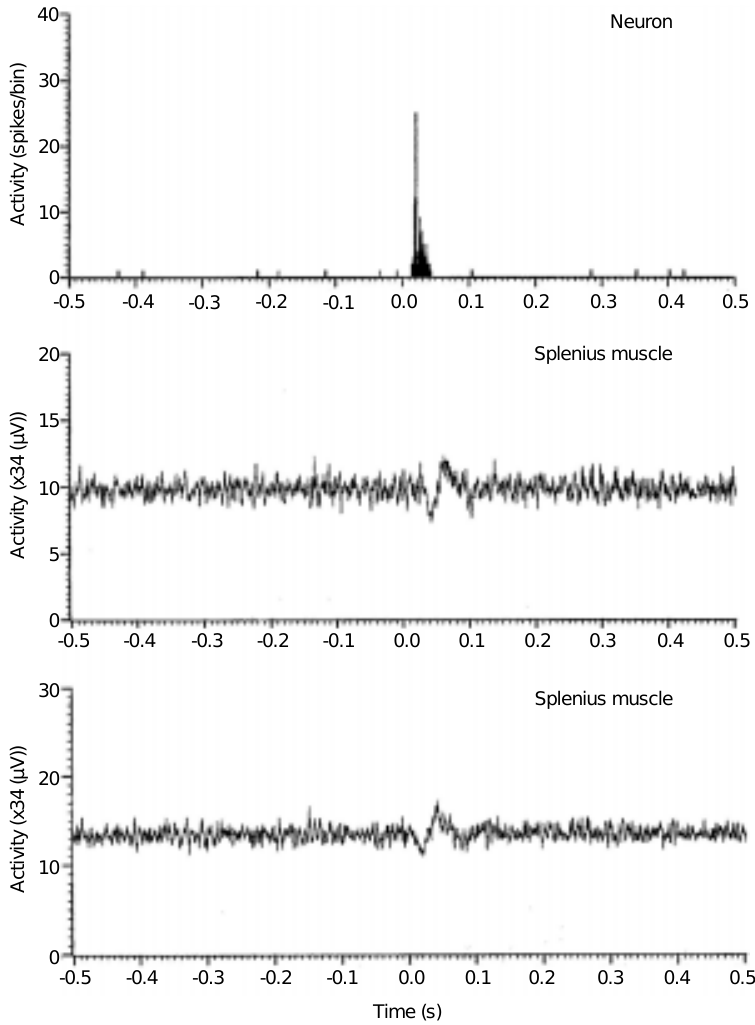
Figure 3. Peri-stimulus time histogram of the responses of a non-serotonergic neuron to the auditory stimulus (1-ms bin width) (upper panel). Corresponding auditory stimulus- triggered average of splenius electromyographic activity (1.5-ms bin width) (middle panel). Spike-triggered average of this same electromyographic activity (1.5-ms bin width) (bottom panel). One hundred auditory stimuli were presented. The neuron was located in the nucleus raphe